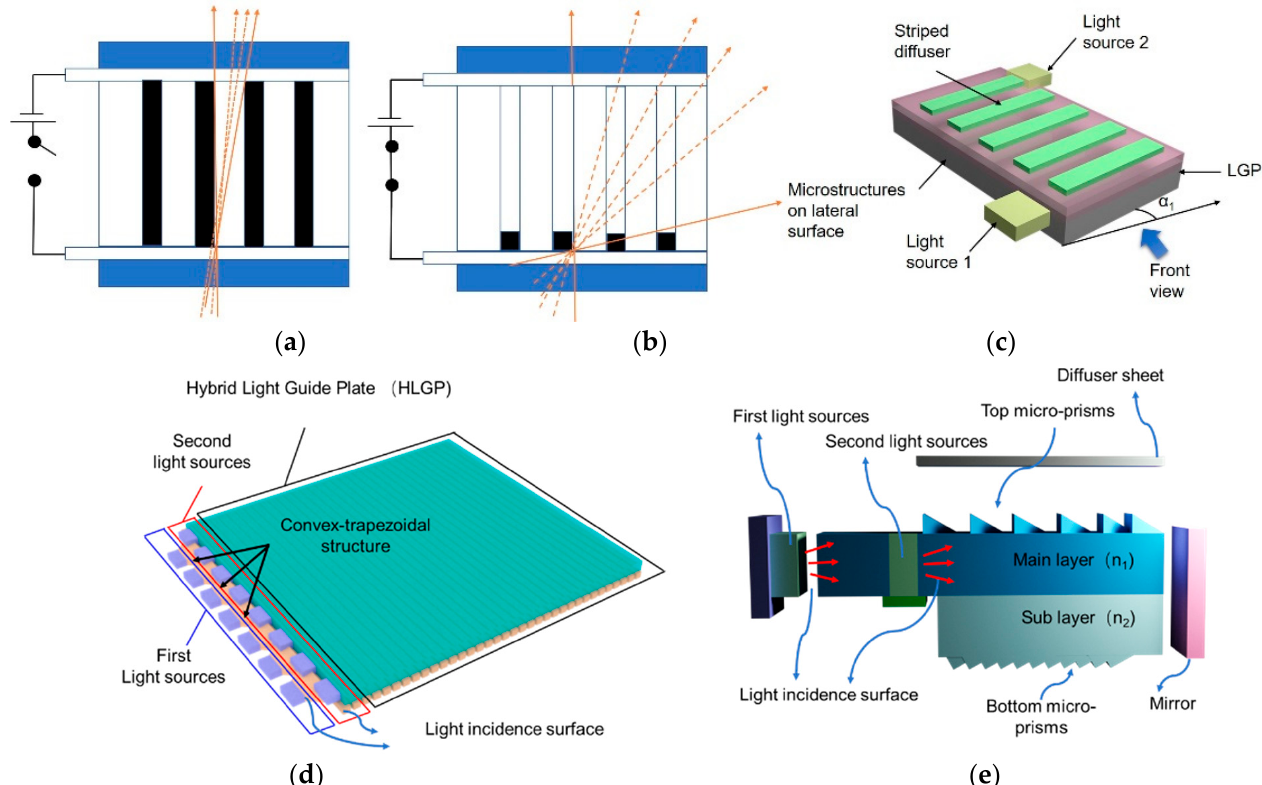
Figure 5. Illustration of concept for ( a ) narrow mode and ( b ) wide mode can be selected electronically. The narrow mode ( a ) is achieved as black particles are fully dispersed, and the wide mode ( b ) is achieved as black particles are completely gathered one side in the optically transparent medium. ( c ) Sketch of the backlight configuration, ( d , e ) optical structure of the dual backlight viewing angle switchable device: ( d ) tilt view; ( e ) side view.